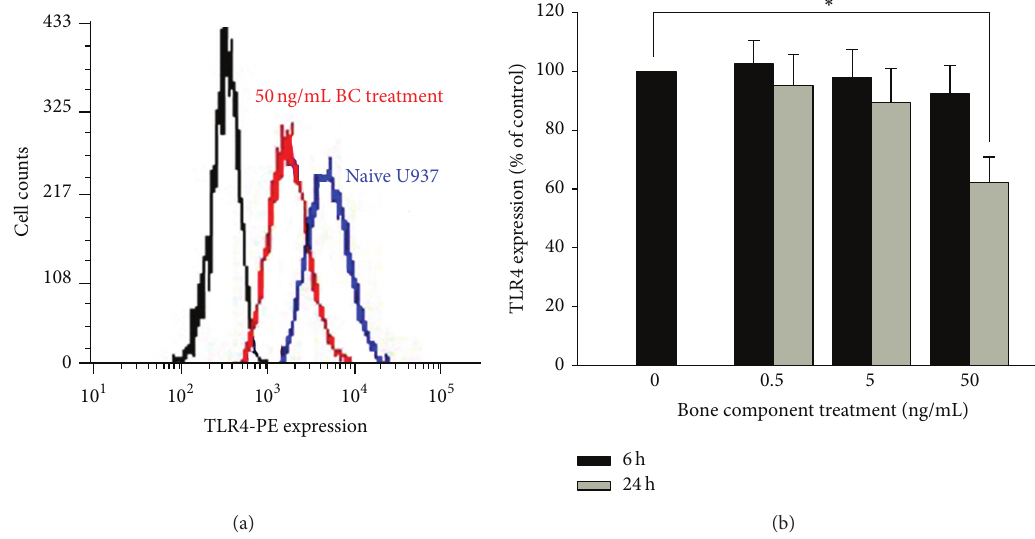
Figure 1: Downregulation of TLR4 surface expression by bone component (BC) exposure in U937 cells. (a) U937 cells were treated with (red graph) or without (blue graph) 50 ng/mL BC for 24 h. The TLR4 membranous portion was stained with a phycoerythrin-conjugated anti- TLR4 antibody and analyzed using flow cytometry. Negative control analyses were performed in the absence of the specific phycoerythrin- conjugated anti-TLR4 antibody (black graph). (b) U937 cells were treated with 0.5–50 ng/mL BC for 6 or 24 hrs. TLR4 levels in U937 cells were examined using flow cytometry, and the results are presented as percentages of the control. Data are presented as mean ± SEM ( 𝑛 = 3 ); ∗ 𝑃 < 0.05 compared with the control